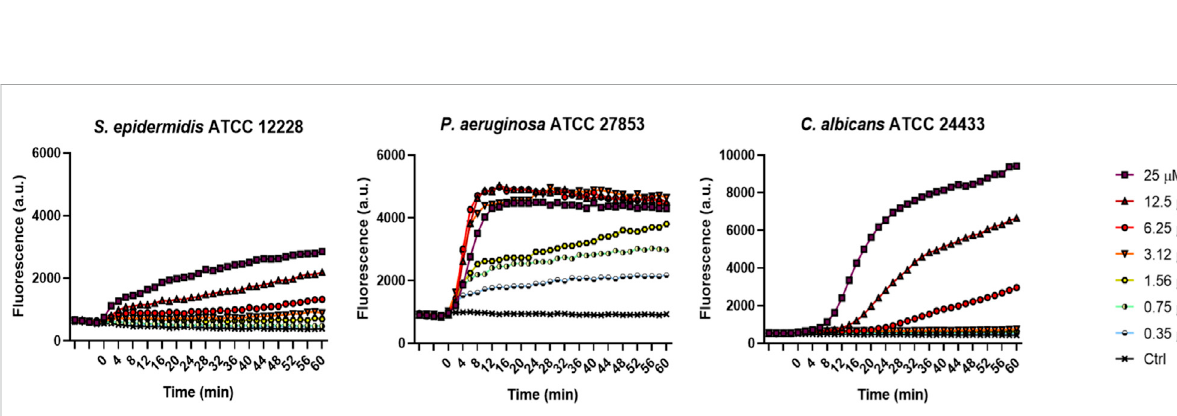
FIGURE 2 Membrane perturbation induced by KDEON as detected by the Sytox Green assay. Time 0 represents peptide addition, after stabilization of the fl uorescence signal of the bacterial suspension in 1 μ M Sytox Green. Values correspond to one representative experiment of three.